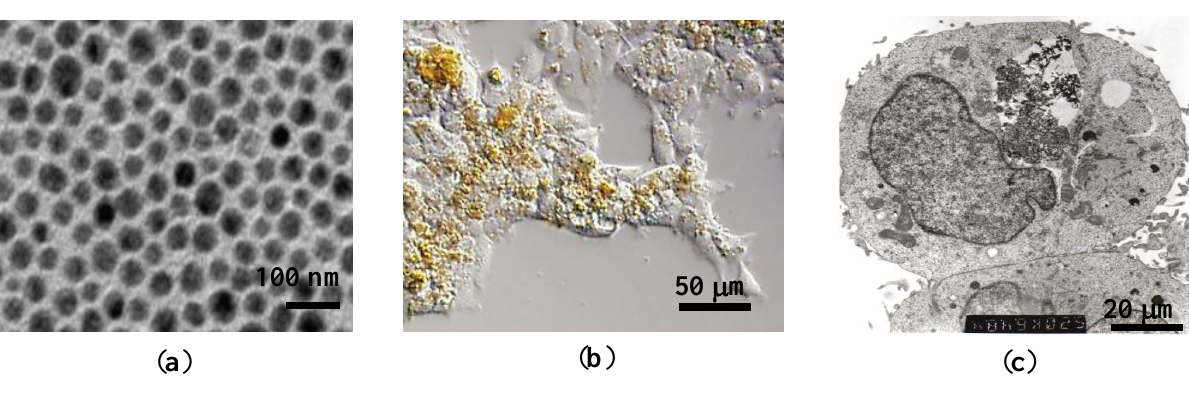
Figure 1. ( a ) TEM image of Au-Fe the nanoparticles (circled) inside HEK